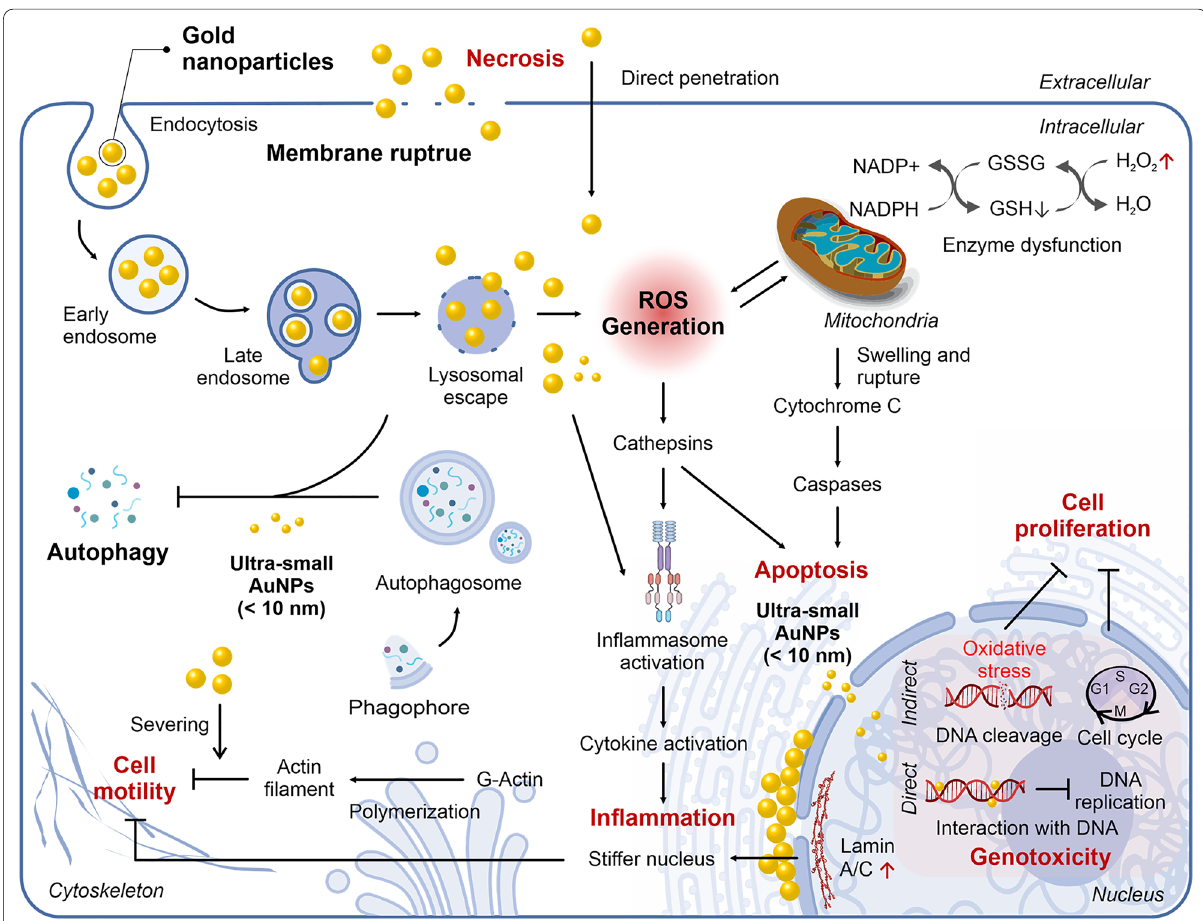
Fig. 6 Potential mechanism of AuNP-induced toxicity. (i) Necrosis: direct physical damage to the cellular membrane, (ii) apoptosis: oxidative stress-triggered intrinsic mitochondrial-mediated pathway, (iii) inhibition of cell motility: interference of actin filament formation and stimulation of lamin A/C overexpression inducing increased nuclear stiffness, (iv) ROS generation: indirectly induced by AuNPs mainly through lysosomal membrane permeabilization, mitochondrial depolarization, and interaction with redox-active enzymes, (v) genotoxicity: primary damage induced by AuNPs including direct interaction with DNA leading to inhibition of DNA replication and indirect DNA cleavage and mutation via oxidative stress, and (vi) inflammation: induction of inflammatory response due to direct and indirect inflammasome activation by